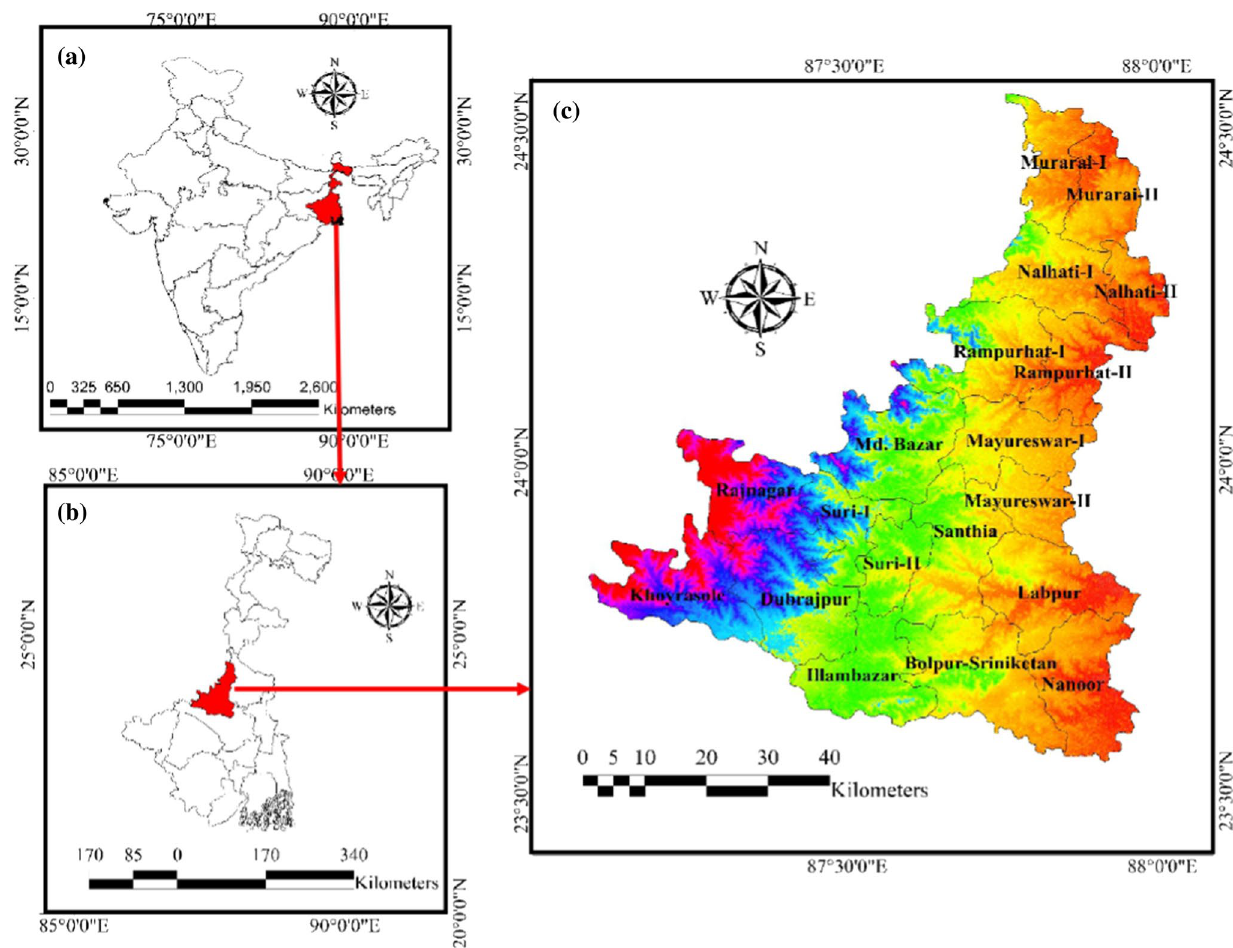
Fig. 1 Location map of a India b West Bengal and c Birbhum